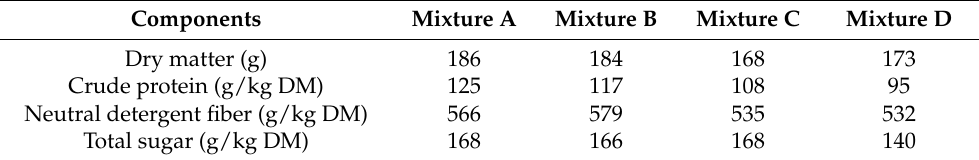
Table 1. Chemical compositions of fresh forage mixtures right before ensiling ( n = 20). Components Mixture A Mixture B Mixture C Mixture D Dry matter (g) 186 Crude protein (g/kg DM) 125 95 Neutral detergent fiber (g/kg DM)